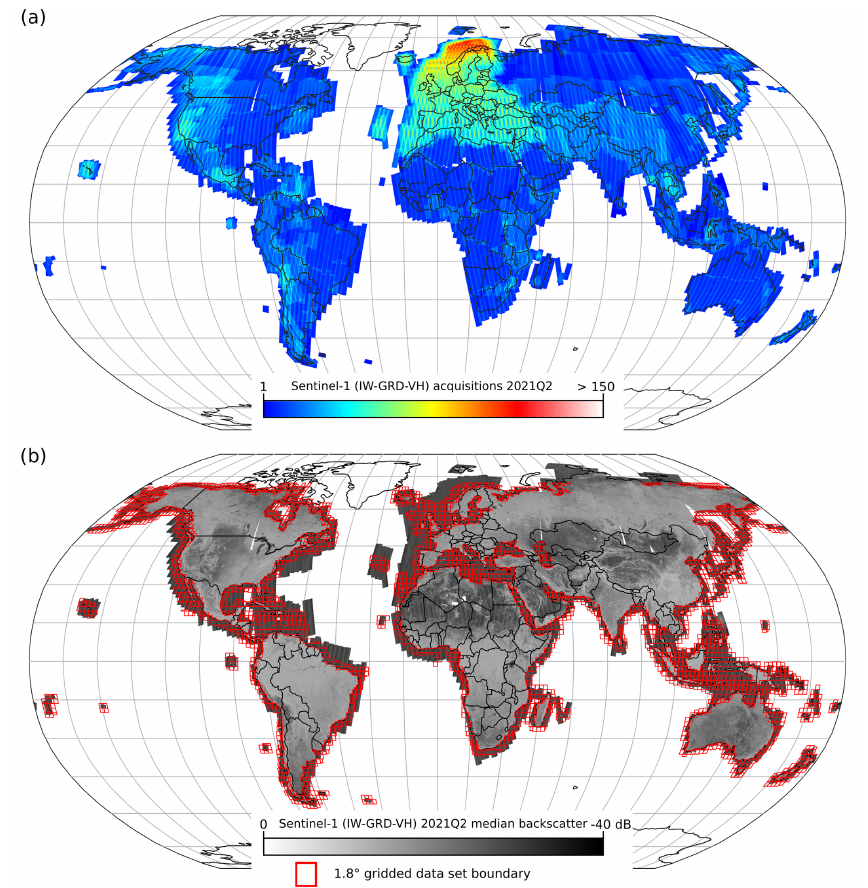
Figure 1. (a) The global distribution of the number of all available Sentinel-1 (IW–GRD–VH) acquisitions for the second quarter (Q2) of 2021. (b) The corresponding median backscatter amplitude and the data set boundary as a 1.8 ◦ grid within a buffer of 200km of the global